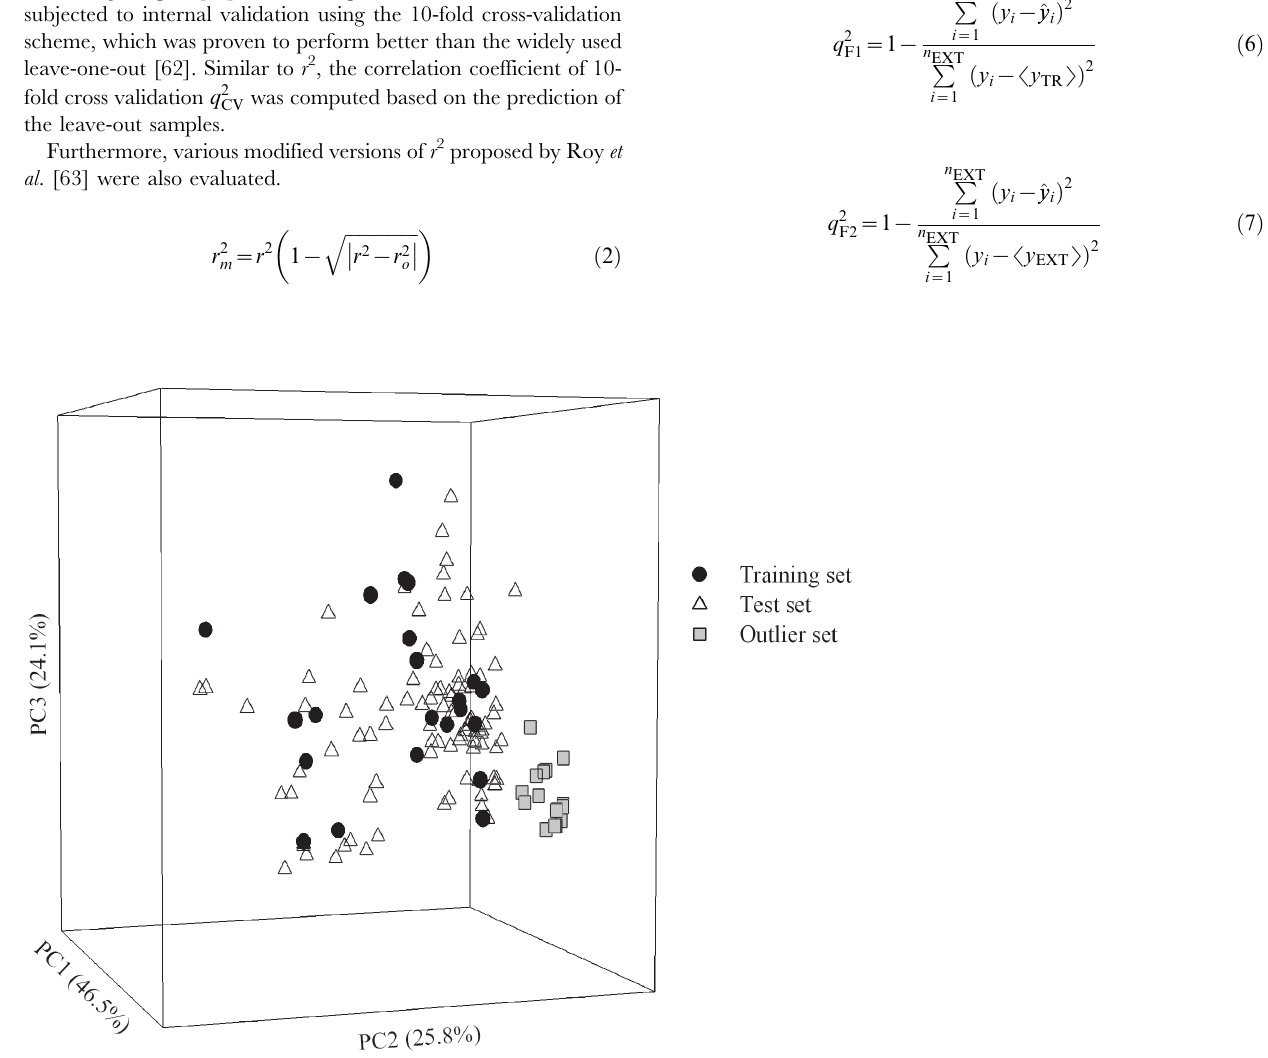
Figure 6. Sample distribution in the chemical space. Molecular distribution for those samples in the training set (blue circle), test set (green triangle), and outlier set (red square) in the chemical space spanned by three principal components. doi:10.1371/journal.pone.0090689.g006 PLOS ONE |